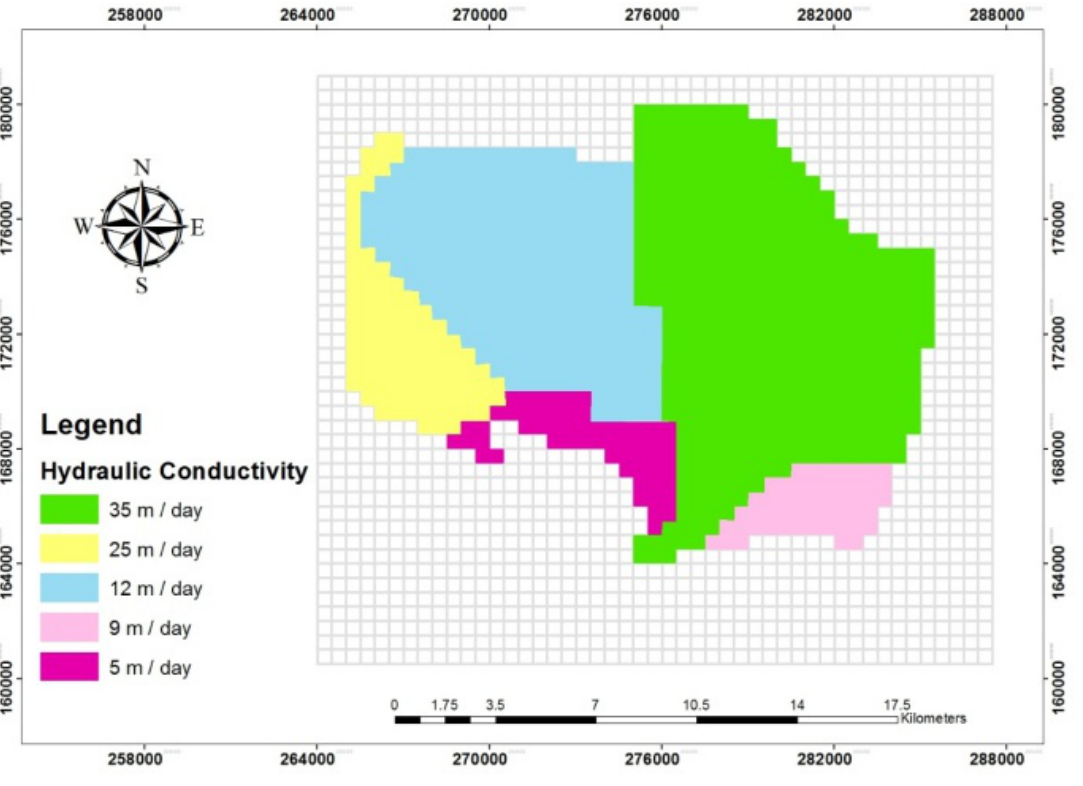
Figure 8. Map of the calibrated HHK for the B-B2/A7 formation.